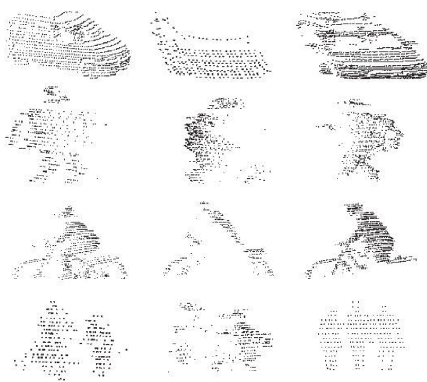
Figure 5: Moving object